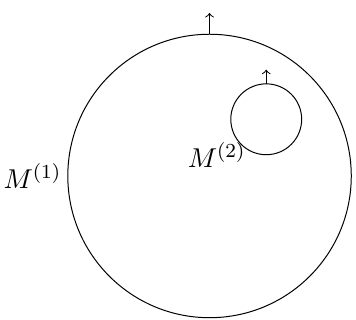
Figure 13 . The con(cid:12)guration of M (1) and M (2) when M (2) is in the interior of M (1) . The arrows are the ^ n ( i ) which point into the exterior of each surface. The polyhedra which lie directly on the interior of a given M ( i ) are associated with Coxeter group elements of length R , while the polyhedra which lie directly on the exterior of a given M ( i ) are associated with elements of length R + 1. Although we have drawn M (1) and M (2) as circles we are not assuming they are spherical, they could be tori, all we are assuming is that they have a well de(cid:12)ned interior and